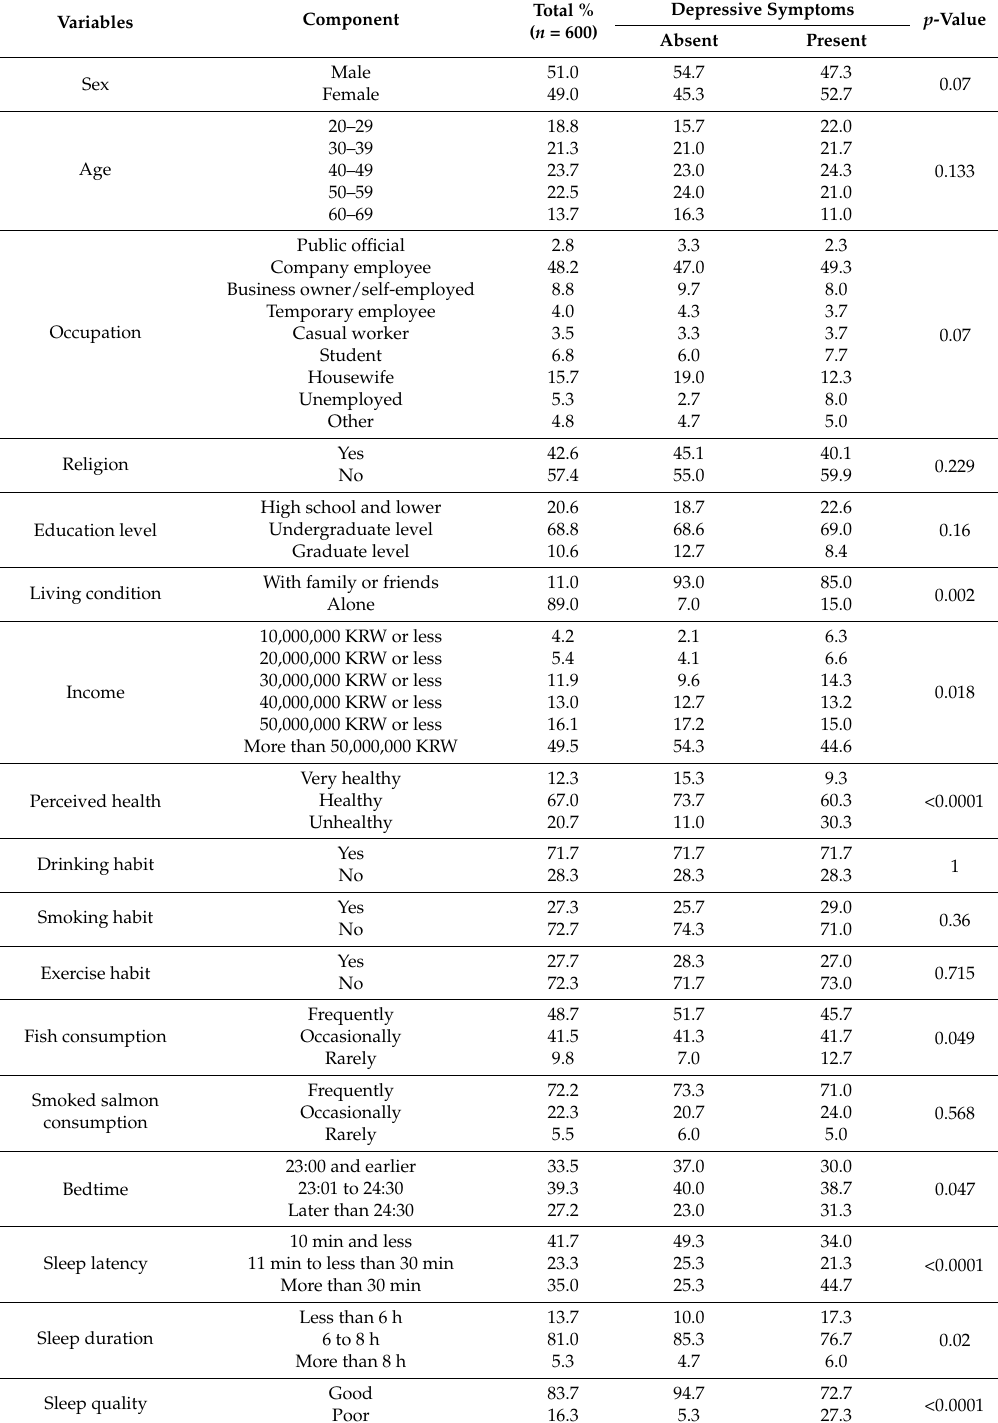
Table 2. The relationship between depressive symptoms, sociodemographic characteristics, and health behavior of the study